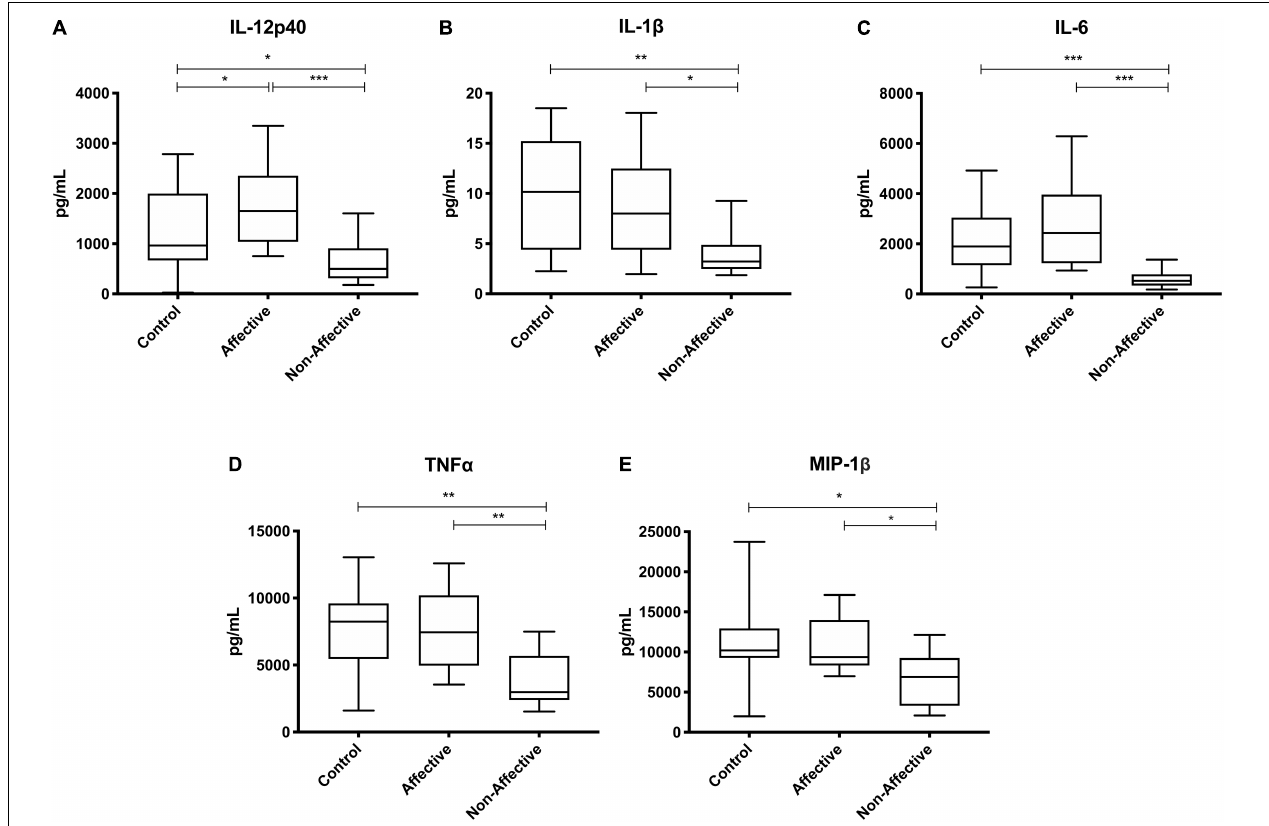
FIGURE 2 | Cytokine/chemokine levels after LPS stimulation. Macrophage cytokine production after culturing for 24 h in RPMI with 10 ng/mL LPS. Macrophages from the NON-group produced decreased concentrations of IL-12p40 (A) , IL-1 β (B) , IL-6 (C) , TNF- α (D) , and MIP-1 β (E) compared to the AFF group after stimulation with LPS. NON-macrophages also produced reduced concentrations of IL-12p40 (A) , IL-1 β (B) IL-6 (C) , TNF- α (D) , and MIP-1 β (E) compared to HC. Box and whiskers graphs depict median, upper and lower interquartile ranges, * p < 0.05, ** p < 0.01, and *** p < 0.001. HC n = 23, AFF n = 14, and NON n =